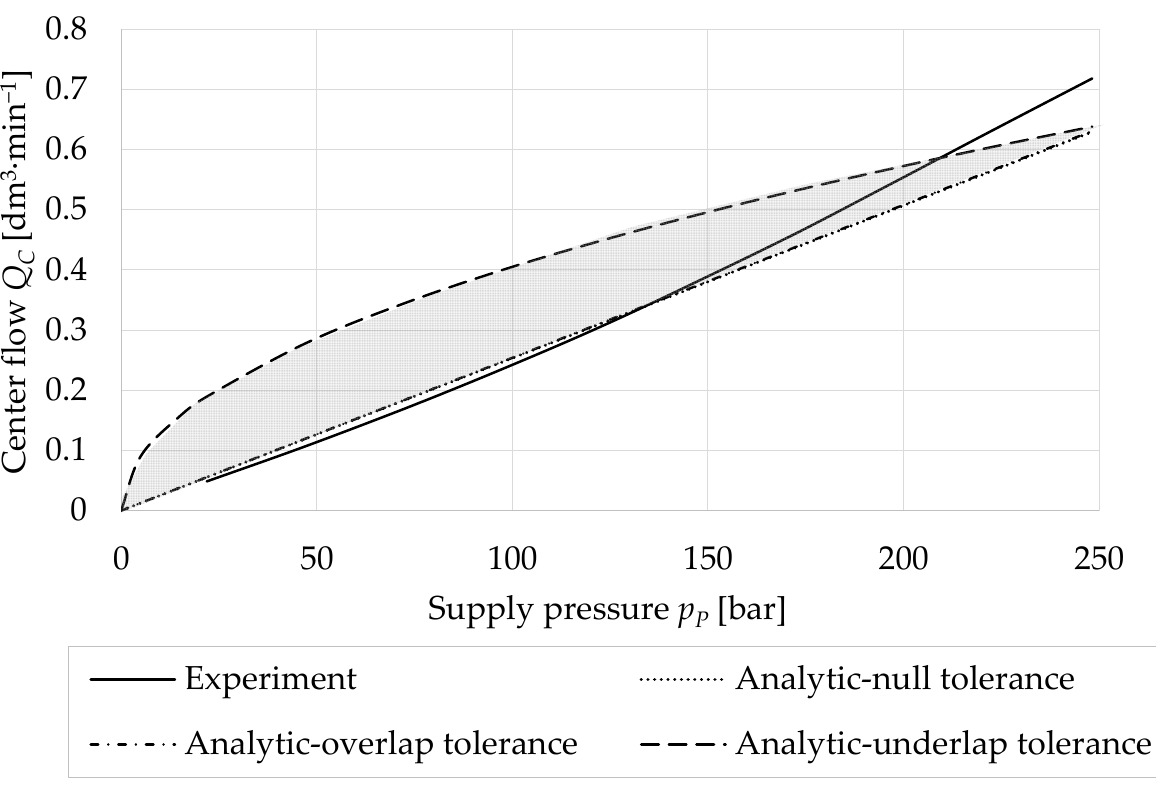
Figure 11. Experimentally determined and analytically calculated center flow curves for different oil temperatures .